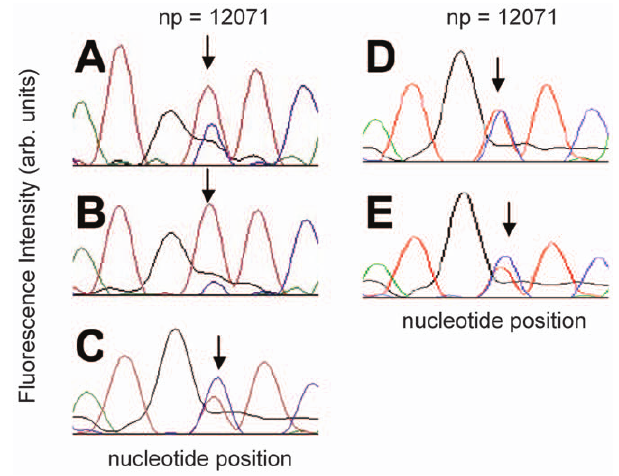
Figure 4. Sequencing chromatograms of single mitochondrion A–E. After optical tweezers capture, transfer and PCR amplification, the five samples that successfully amplified with primer set 43 or 43i were sequenced. Each sample showed the heteroplasmy (C nucleotide (blue) and T nucleotide (red)) at np 12071 highlighted with the arrow.